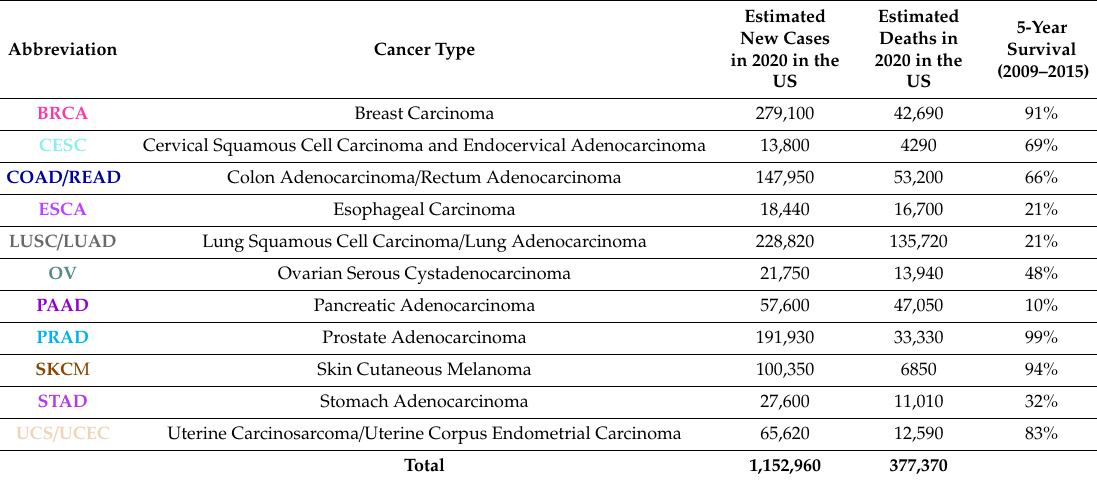
Table 1. List of cancer types included in the meta-analysis.